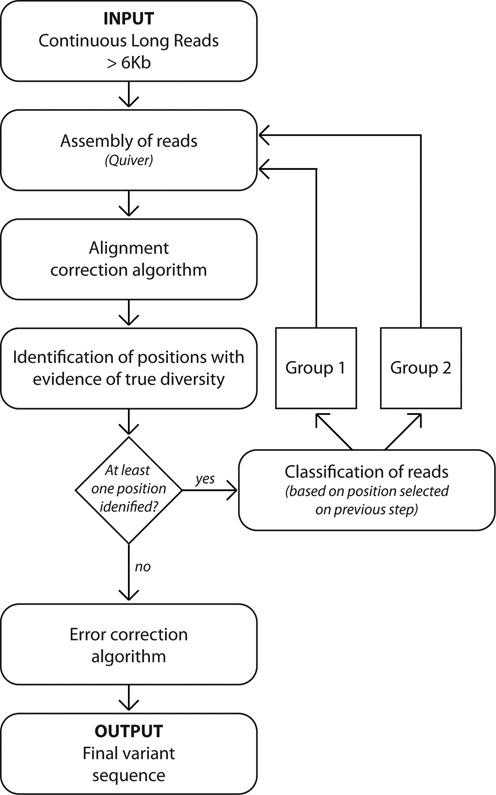
Schematic view of the main steps involved in the workflow. The workflow consists of a number of steps that initially align the Continuous Long Reads, then minimizes the impact of insertions by performing an Alignment Correction, then identifies positions with true diversity disregarding deletions, and classifies reads into two groups using a distance method based on positions selected in the previous step. The recurrent implementation of these procedures to each subgroup generated increases the homogeneity of the sequences until all the sequences contained in one subgroup were highly likely obtained from sequencing the DNA molecules with the same DNA sequence. Finally, an Error Correction algorithm is implemented over the derived sequences in order to increase their QV.